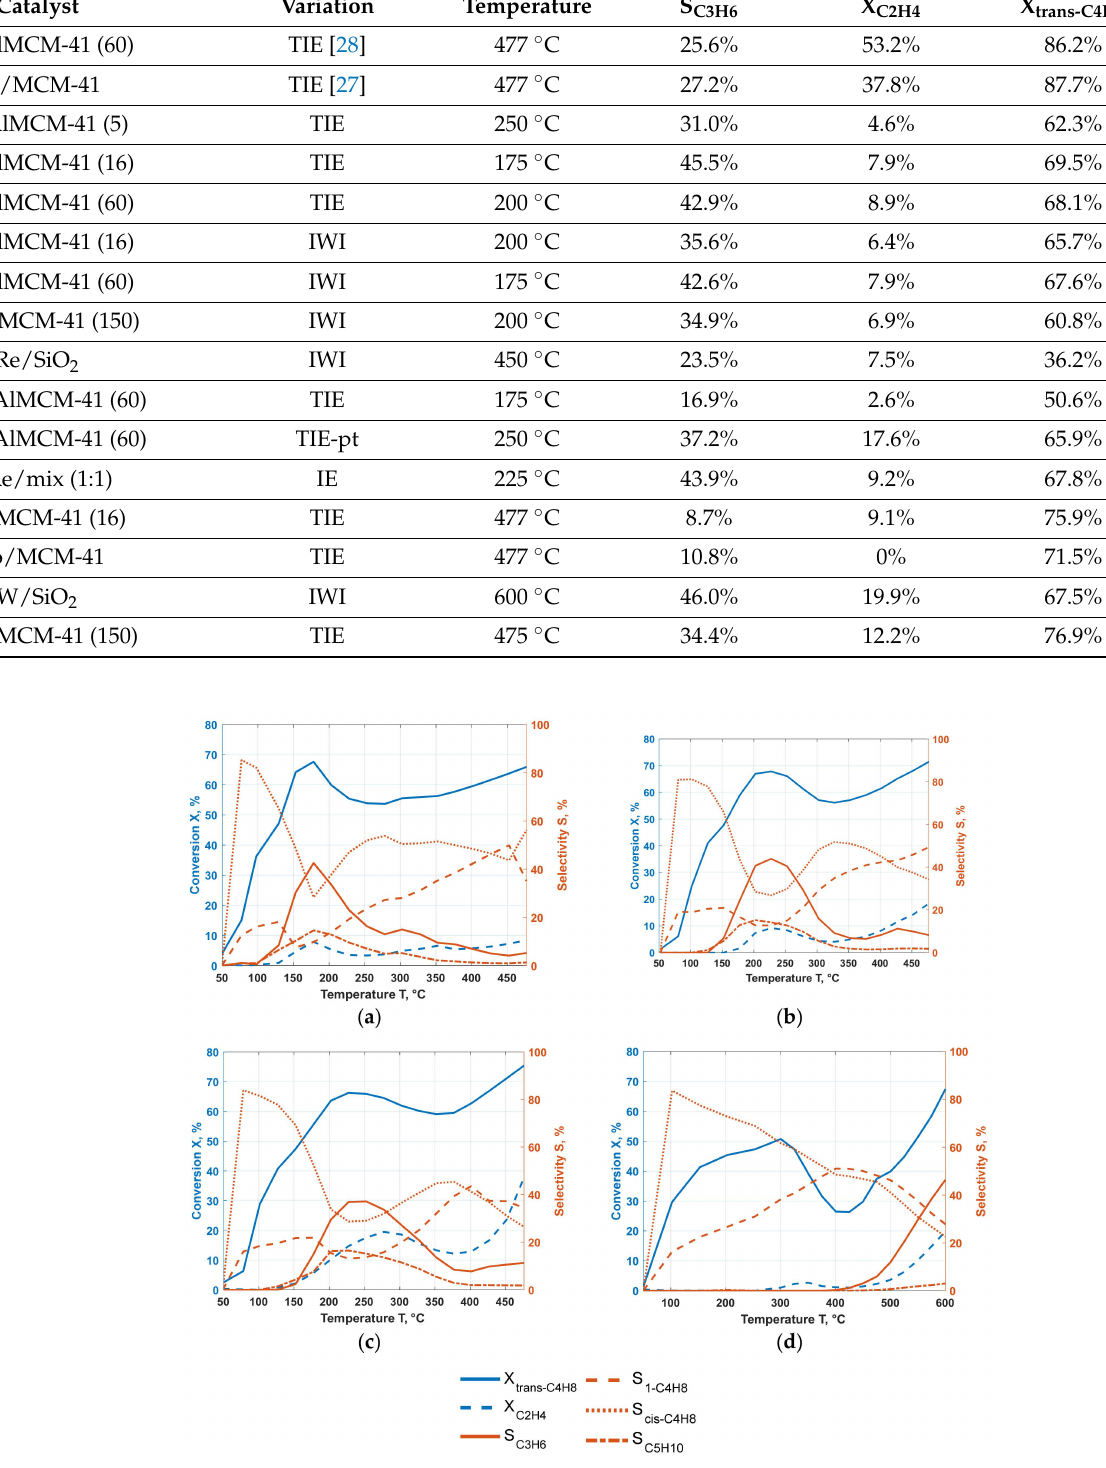
Figure 1. Conversion Xi of the reactants (ethene and trans-butene) on the left axis and selectivity of the analyzable production Sj (propene, 1-butene, cis-butene and pentene) on the right axis for varying reaction temperature for ( a ) Re/AlMCM-41 (60), ( b ) NiRe/mix (1:1), ( c ) NiRe/AlMCM-41 (60) pretreated under nitrogen for 1 h at 500 ◦ C and ( d ) W/SiO 2